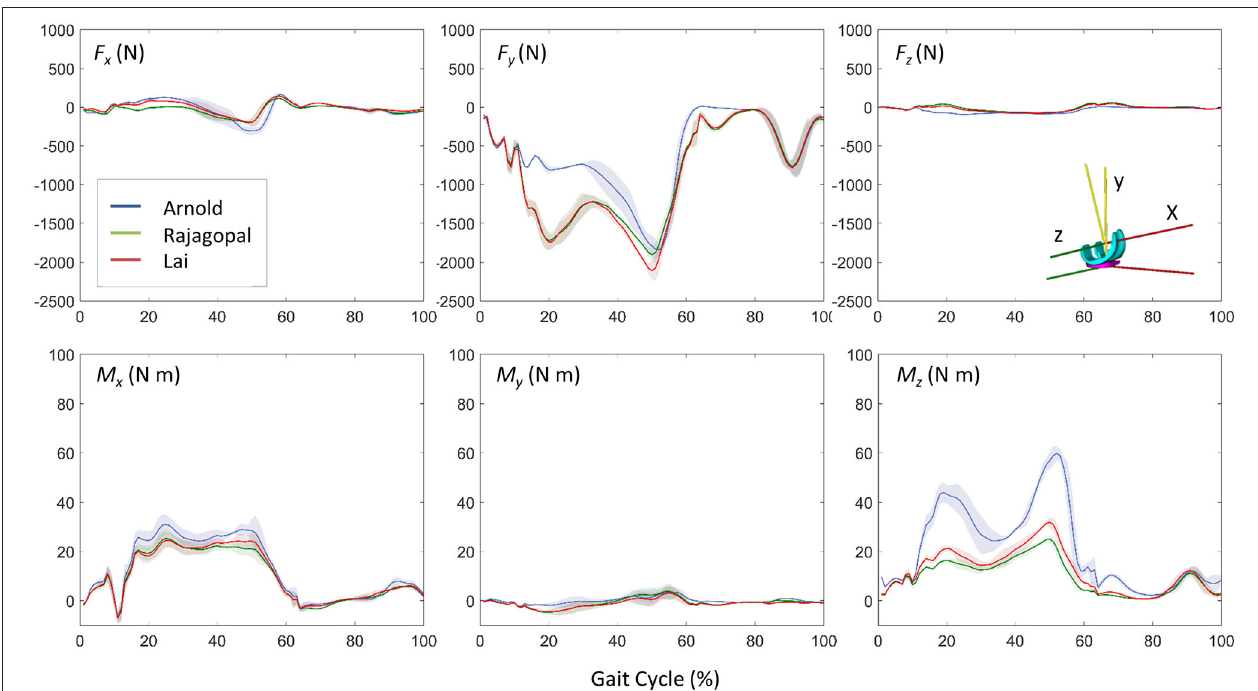
FIGURE 5 | Dynamic results comparison for the three models: three force and moment components acting on the TI predicted by the musculoskeletal models (mean ± SD).